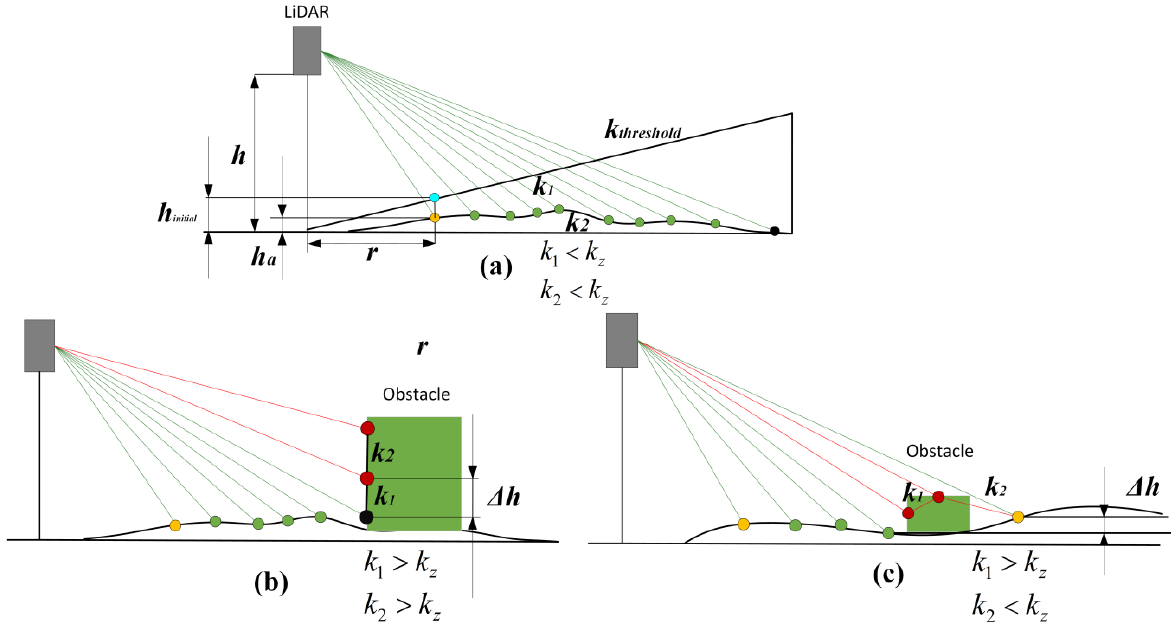
Figure 3. LiDAR scan models of one segment in ground candidate point selection process. ( a ) scan model 1. ( b ) scan model 2. ( c ) scan model 3.